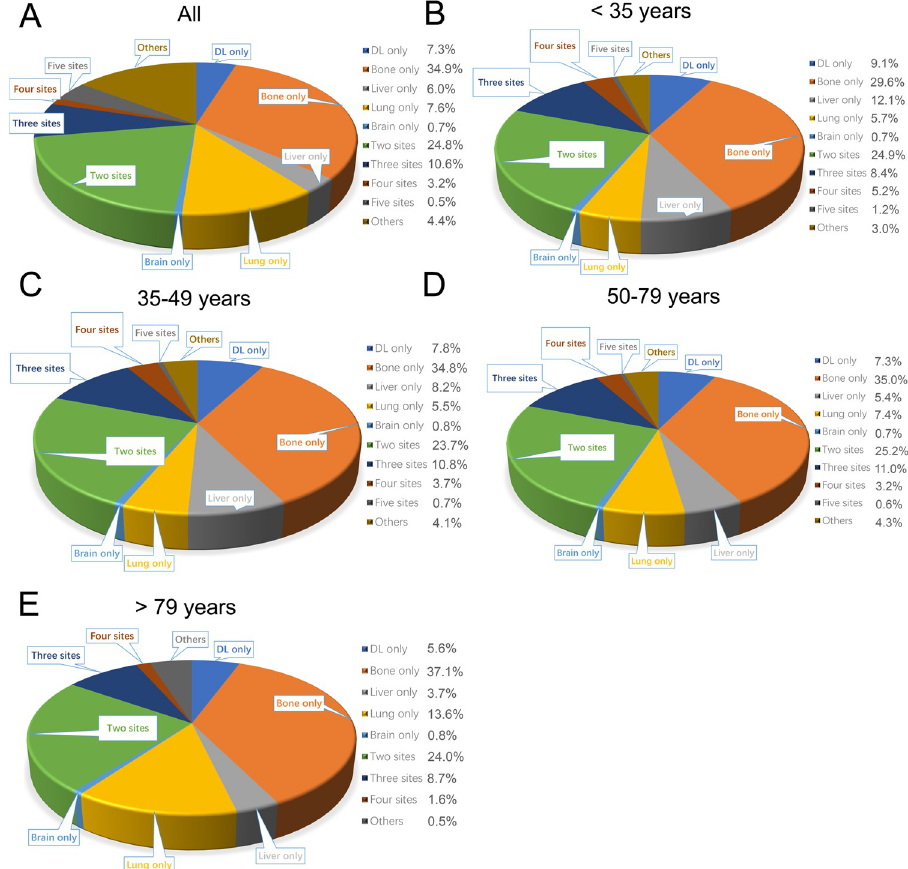
Fig 2. Distribution of single-organ and multi-organ metastatic sites in MBC patients with different age. ( A ) All patients; ( B ) Younger patients ( < 35 yrs); ( C ) Middle-aged patients (35–49 yrs); ( D ) Middle-aged patients (50–79 yrs); ( E ) Older patients ( > 79 yrs).